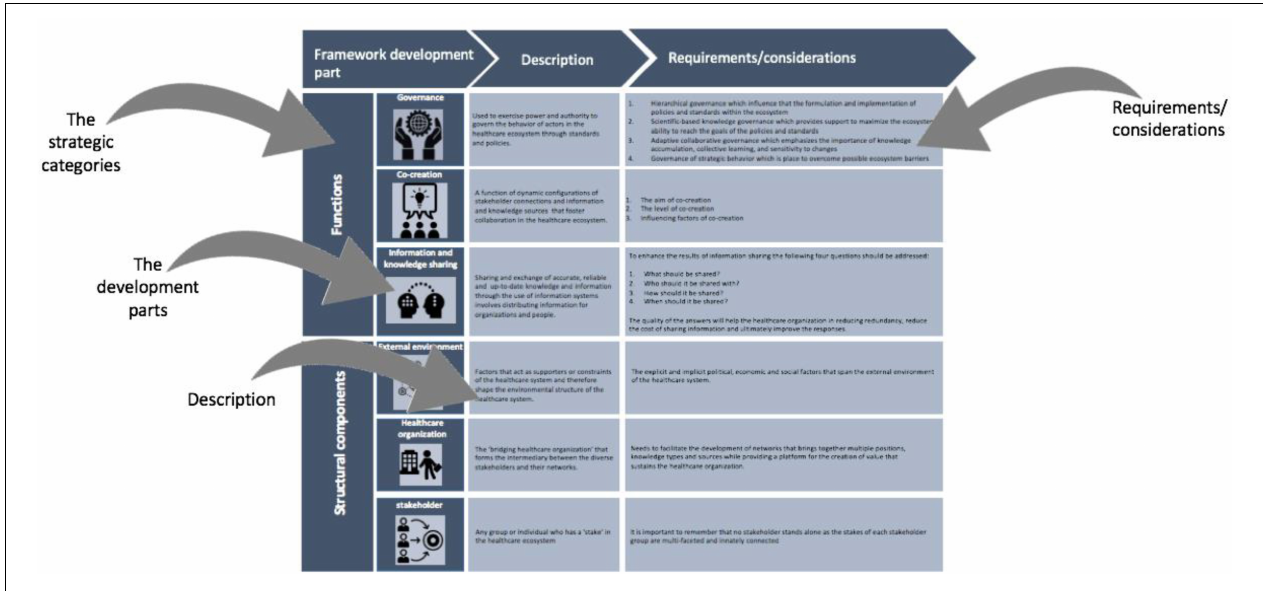
FIGURE 10 | The tool guideline of the final management